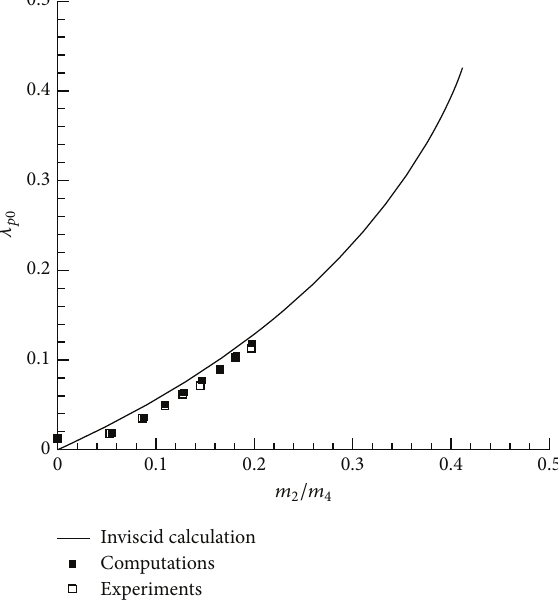
Figure 3: Locations where total pressures are measured behind the jet injector. This arrangement is in accordance with AIR1419 (1999).